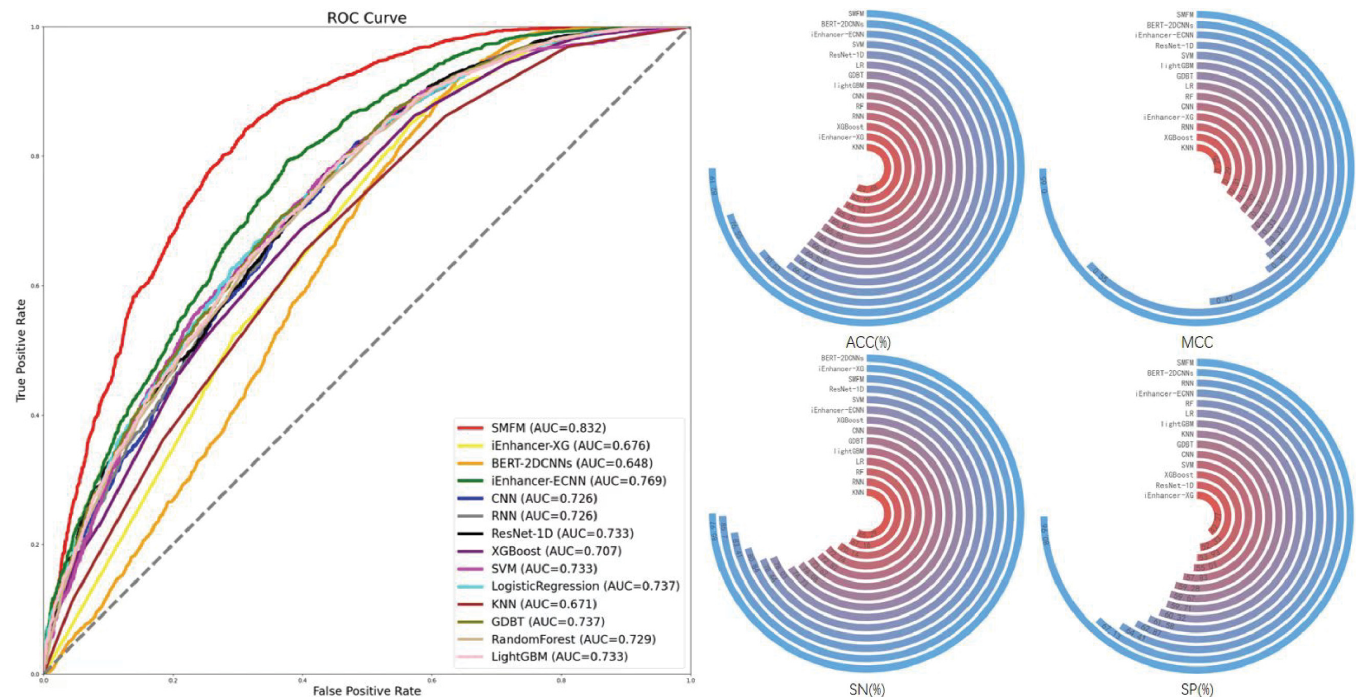
Fig 12. Performance of other enhancer identification methods compared to SMFM on a large-scale dataset, where the left panel illustrates the AUC performance of SMFM, baseline methods, classical deep learning networks, and multiple machine learning classifiers. The right panel shows the four performance measure metrics (ACC, MCC, SN and SP) for each